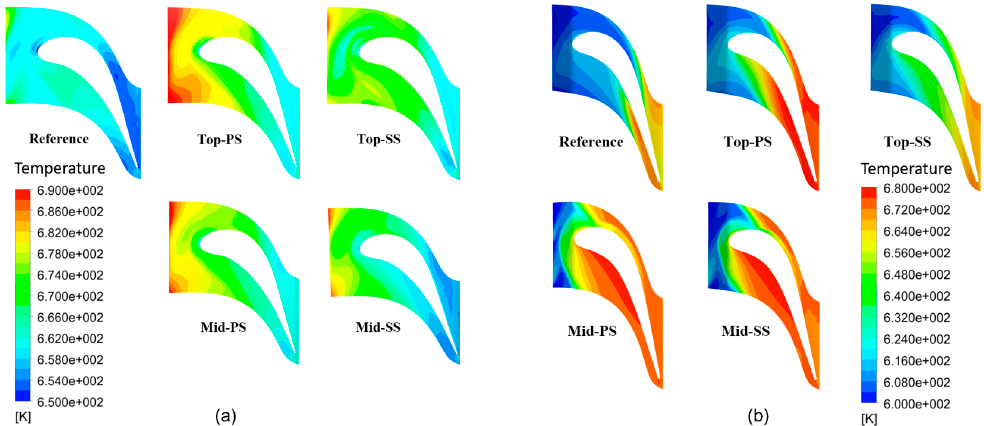
Figure 7. Temperature distribution on the S2 vane at the ( a ) hub and ( b ) shroud under different damaged-blade conditions.